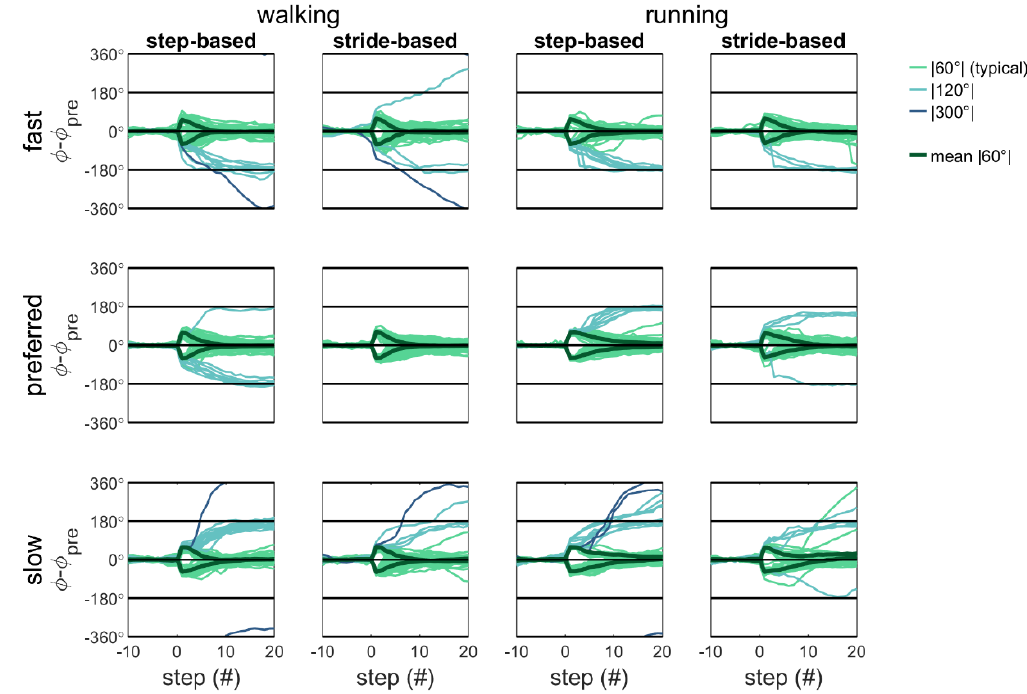
Figure 6. Relative phase for the valid responses to the perturbations with the mean pre-perturbation subtracted. The relative phase for walking is presented on the left side and that for running on the right side. A positive perturbation is a delay in the cues and a negative perturbation is an advance in the cues.